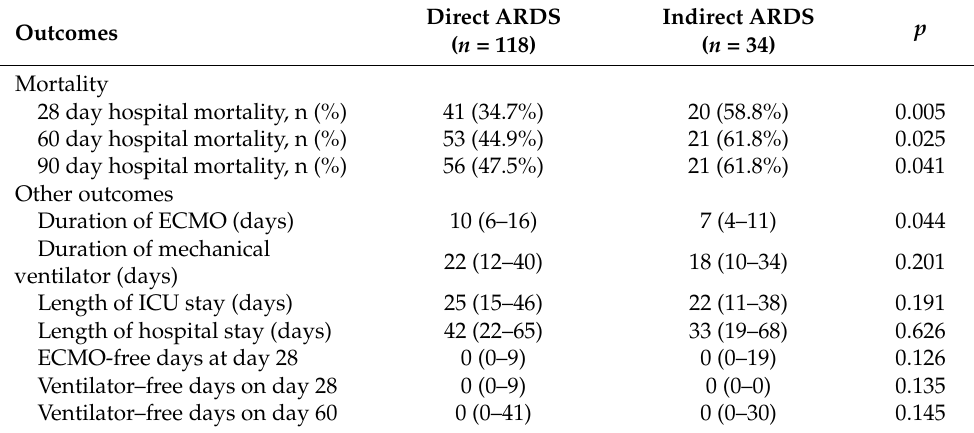
Table 2. Clinical outcomes of direct and indirect ARDS patients with ECMO.